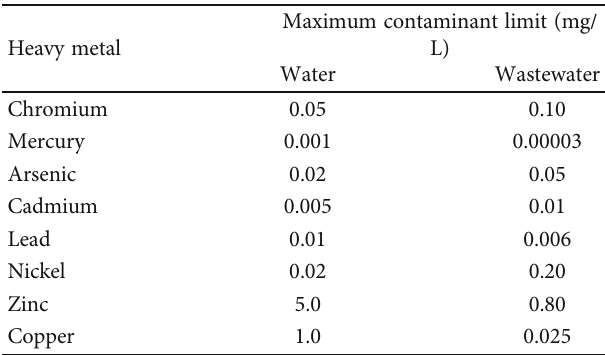
Table 1: Maximum discharge limits of some heavy metals in water and wastewater